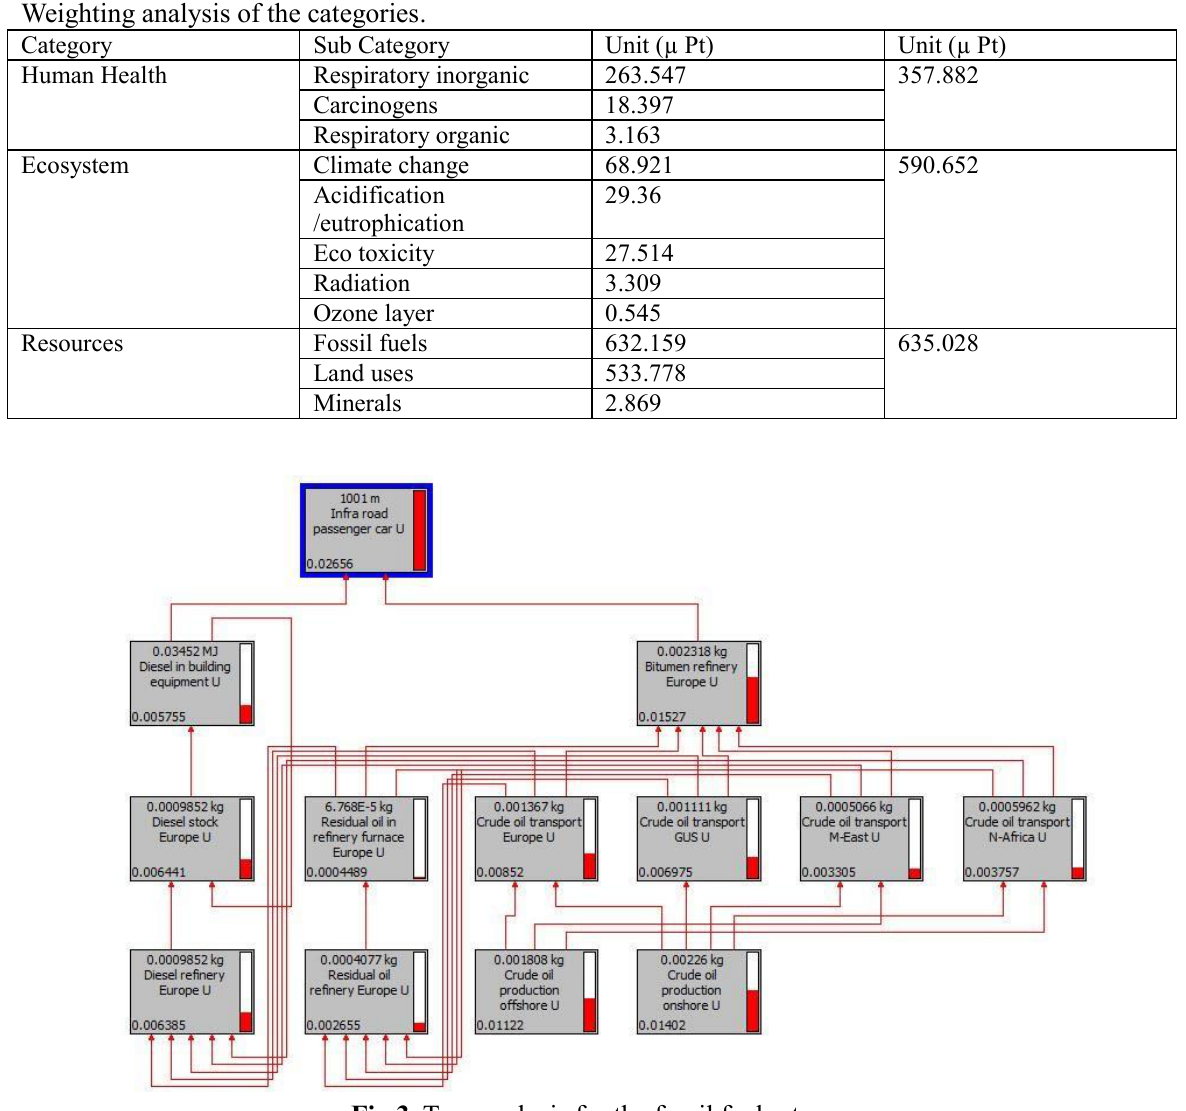
Fig 3. Tree analysis for the fossil fuels stream.